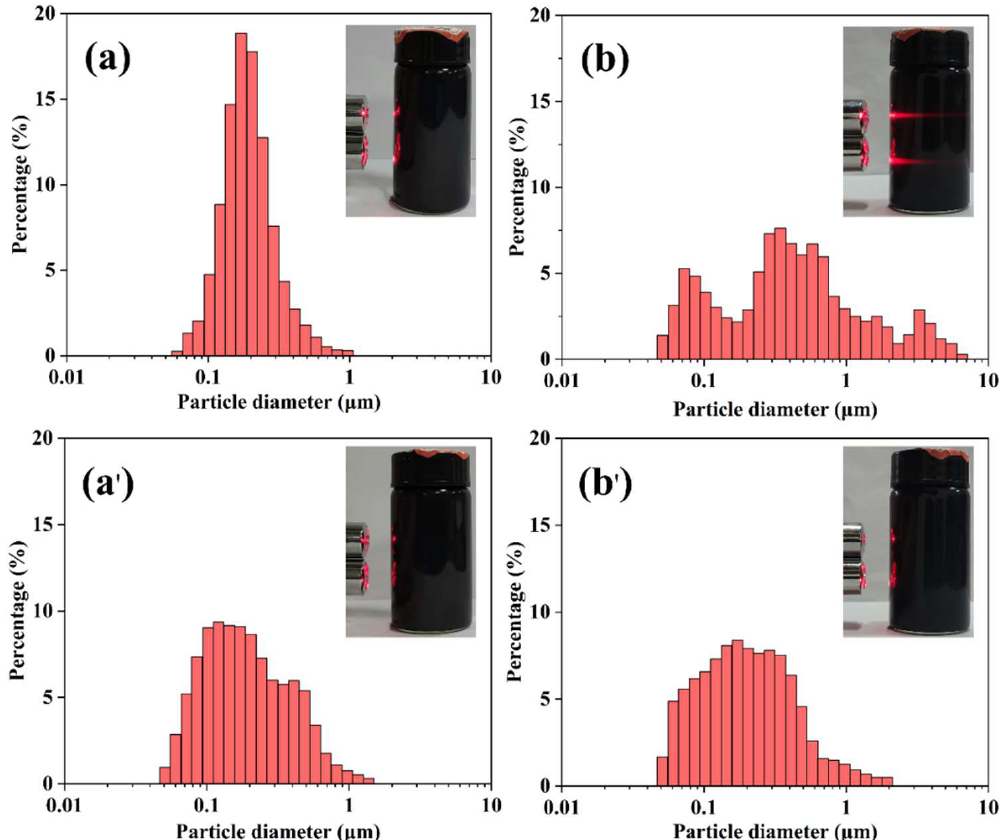
Figure 4. The particle size distribution of 0.2 wt% CCNTs ( a , b ) and 0.2 wt% SCNTs ( a’ , b’ ) in water ( a and b refer to 1 min and 24 h, respectively, the embedded graphs were the corresponding dispersity